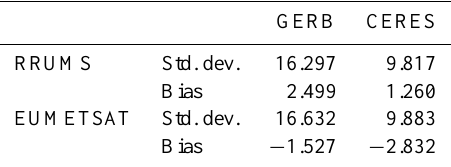
Table 2. Comparison between SEVIRI-based RRUMS retrieval, EUMETSAT retrieval and corresponding CERES and GERB mea- surements for the scene depicted in Fig. 6. Bias and standard devia- tion in Wm − 2 . GERB CERES RRUMS Std. dev.